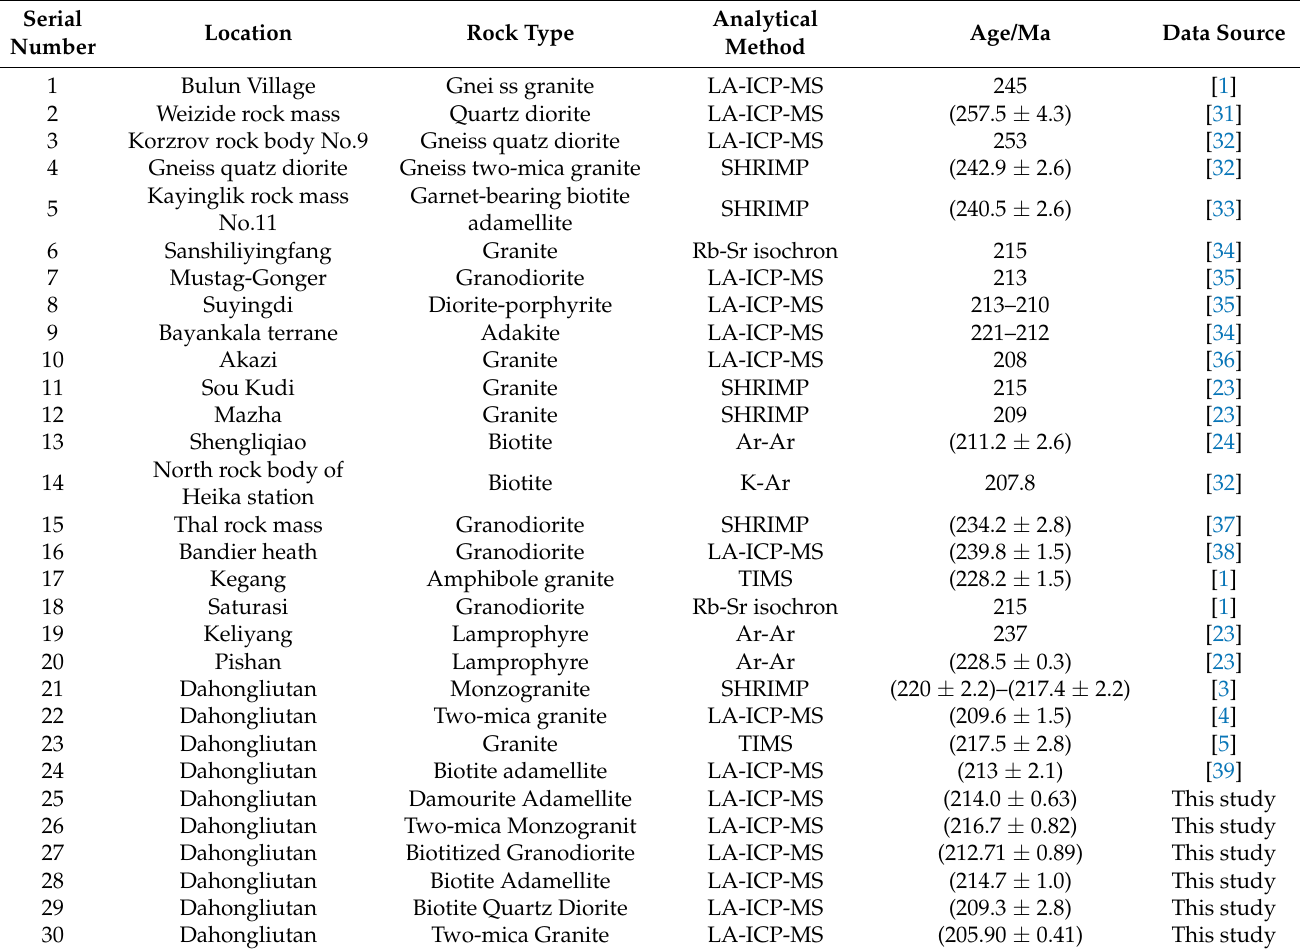
Table 4. Isotopic ages of Indosinian intrusive rocks in the Western Kunlun